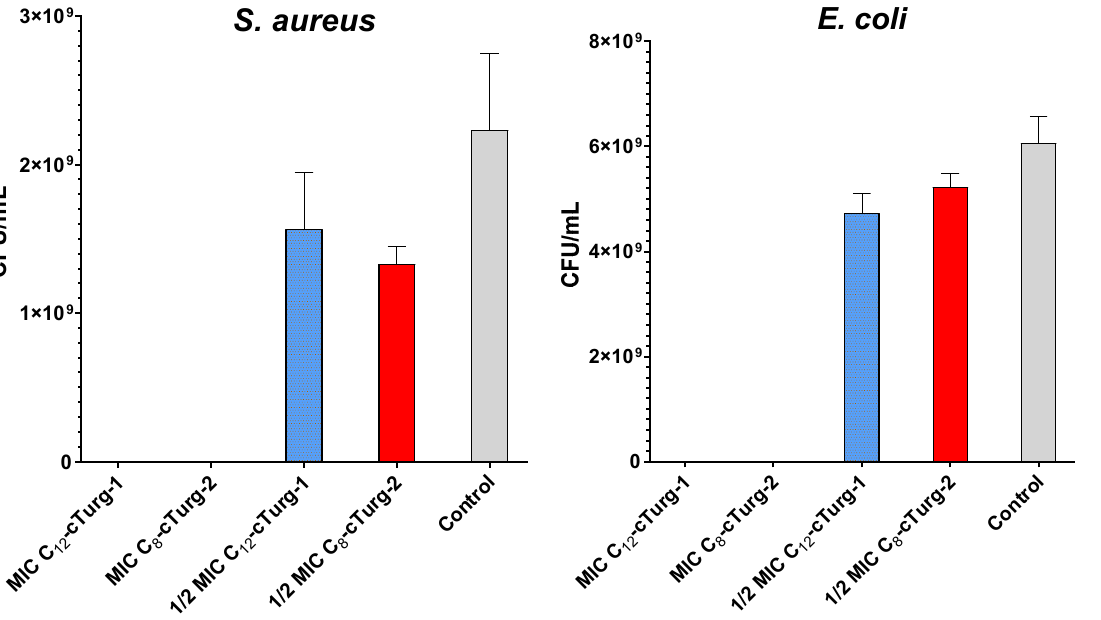
Figure 6. Bactericidal activity of C 12 -cTurg-1 and C 8 -cTurg-2 against S. aureus and E. coli. Colony- forming units (CFU) per mL bacterial inoculum were counted after treatment with MIC (4 µg/mL), 1/2 × MIC and no treatment (Control). Each bar presents the mean of three replicates ± SD.